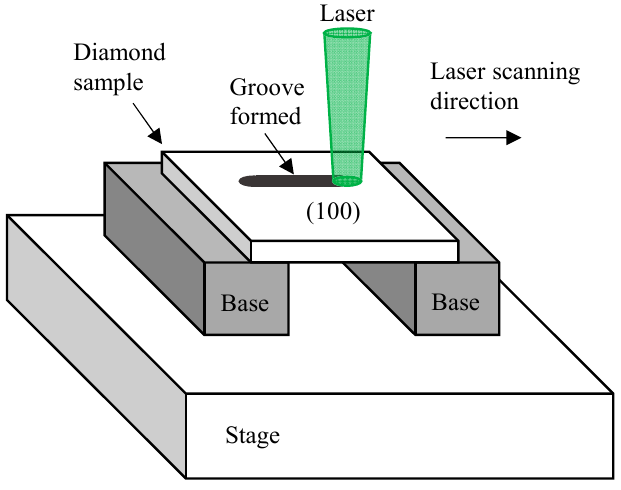
Figure 1. Schematic of the experimental set-up.